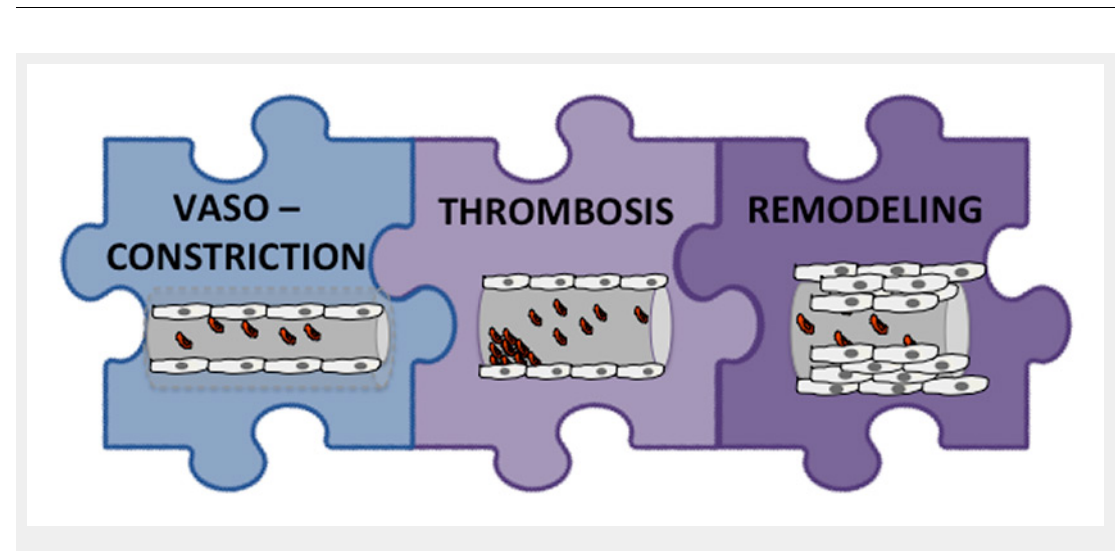
The three pieces in the pathogenesis of pulmonary hypertension. Pure vasoconstriction occurs in early disease; microthrombotic events are observed at increasing frequency during evolution of the disease; remodelling of the small pulmonary arteries is arguably the most important factor.